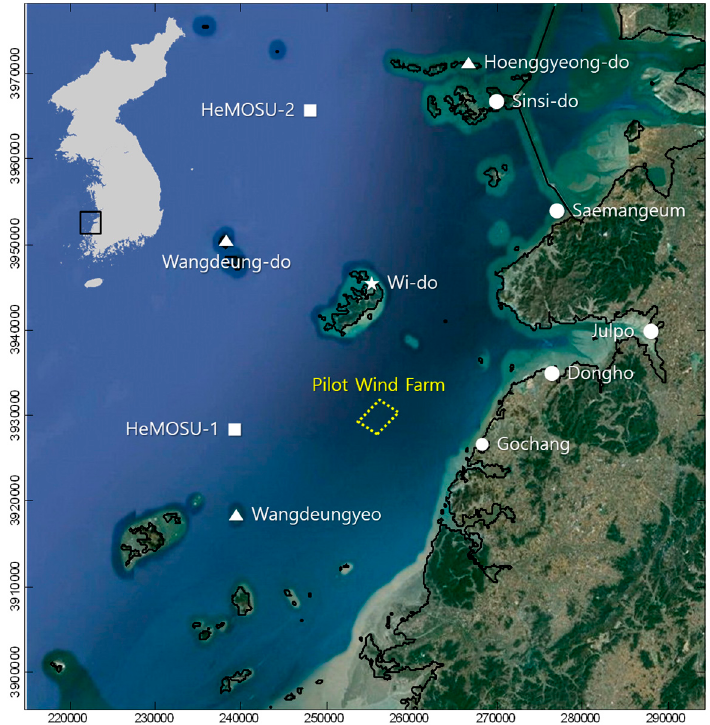
Figure 2. Location of in-situ measurement sites around the pilot wind farm of the ‘Southwest Offshore Wind Project’ (yellow lozenge in the map center). Filled squares, triangles, circles and star symbols indicates offshore, island, onshore meteorological towers and a tidal station.